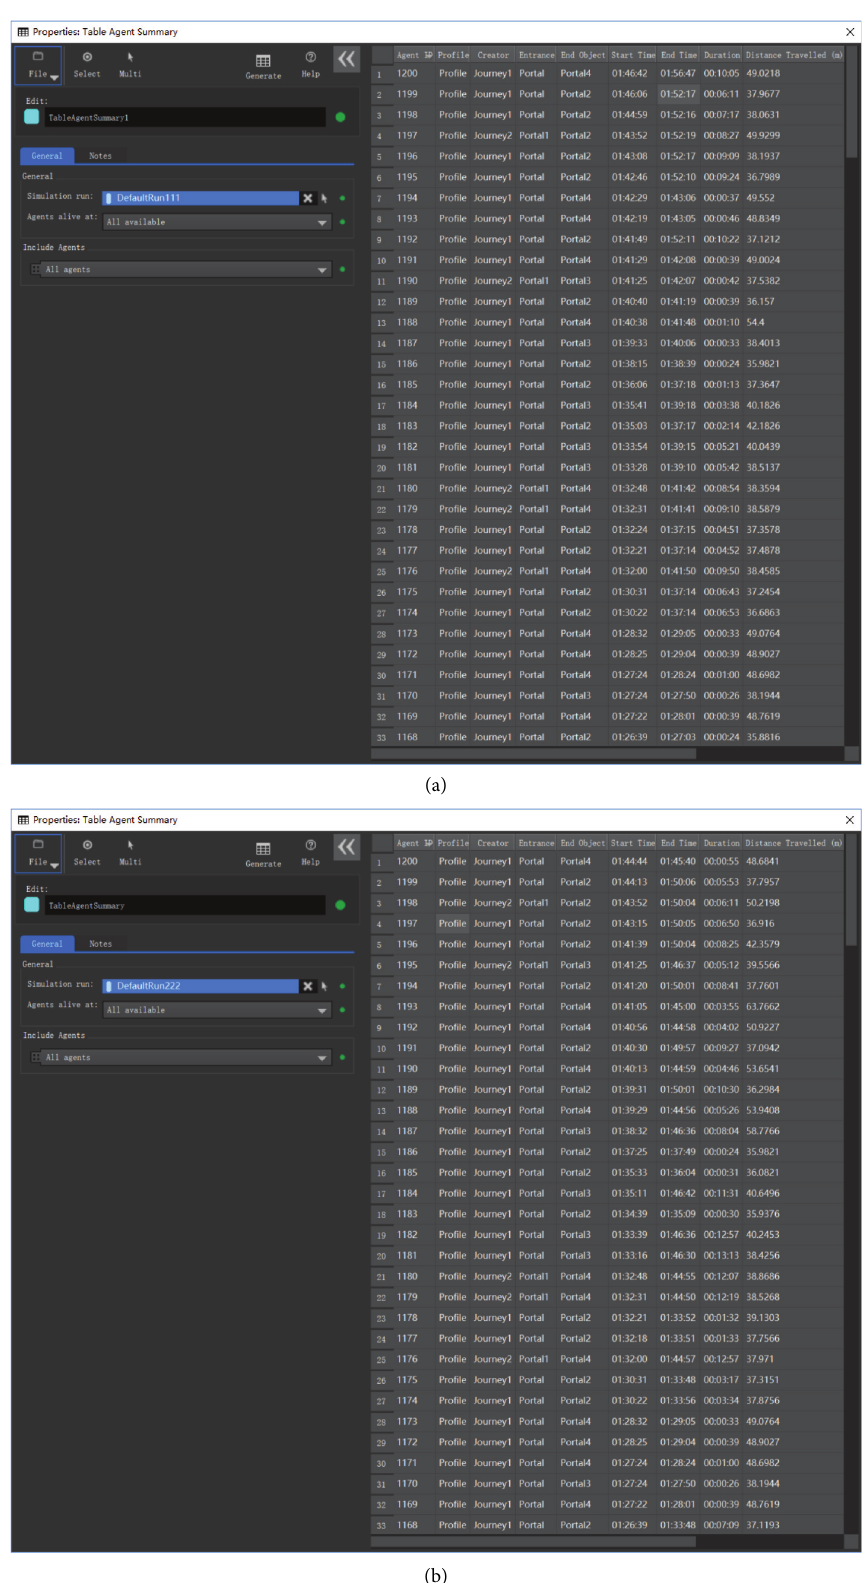
Figure 9: Summary table of Massmotion simulation individual. (a) Summary table of simulated individuals before optimization. (b) Summary table of simulated individuals after